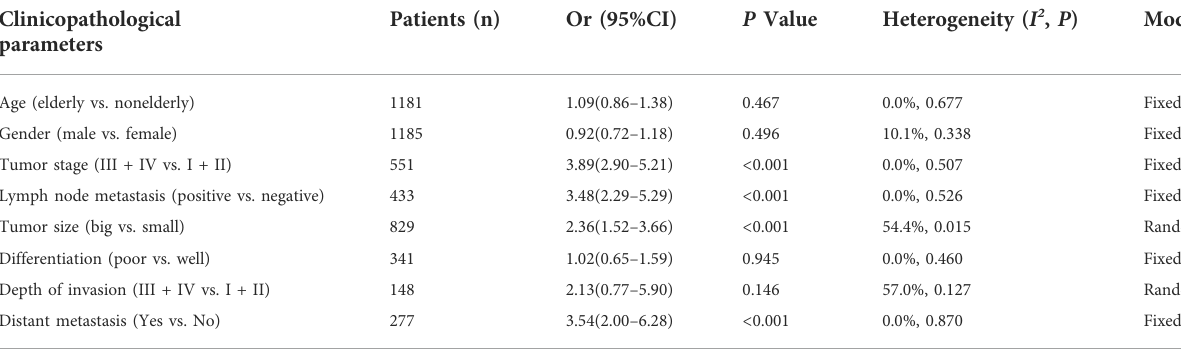
TABLE 3 Association of HOXA-AS2 expression with clinicopathological features. Clinicopathological